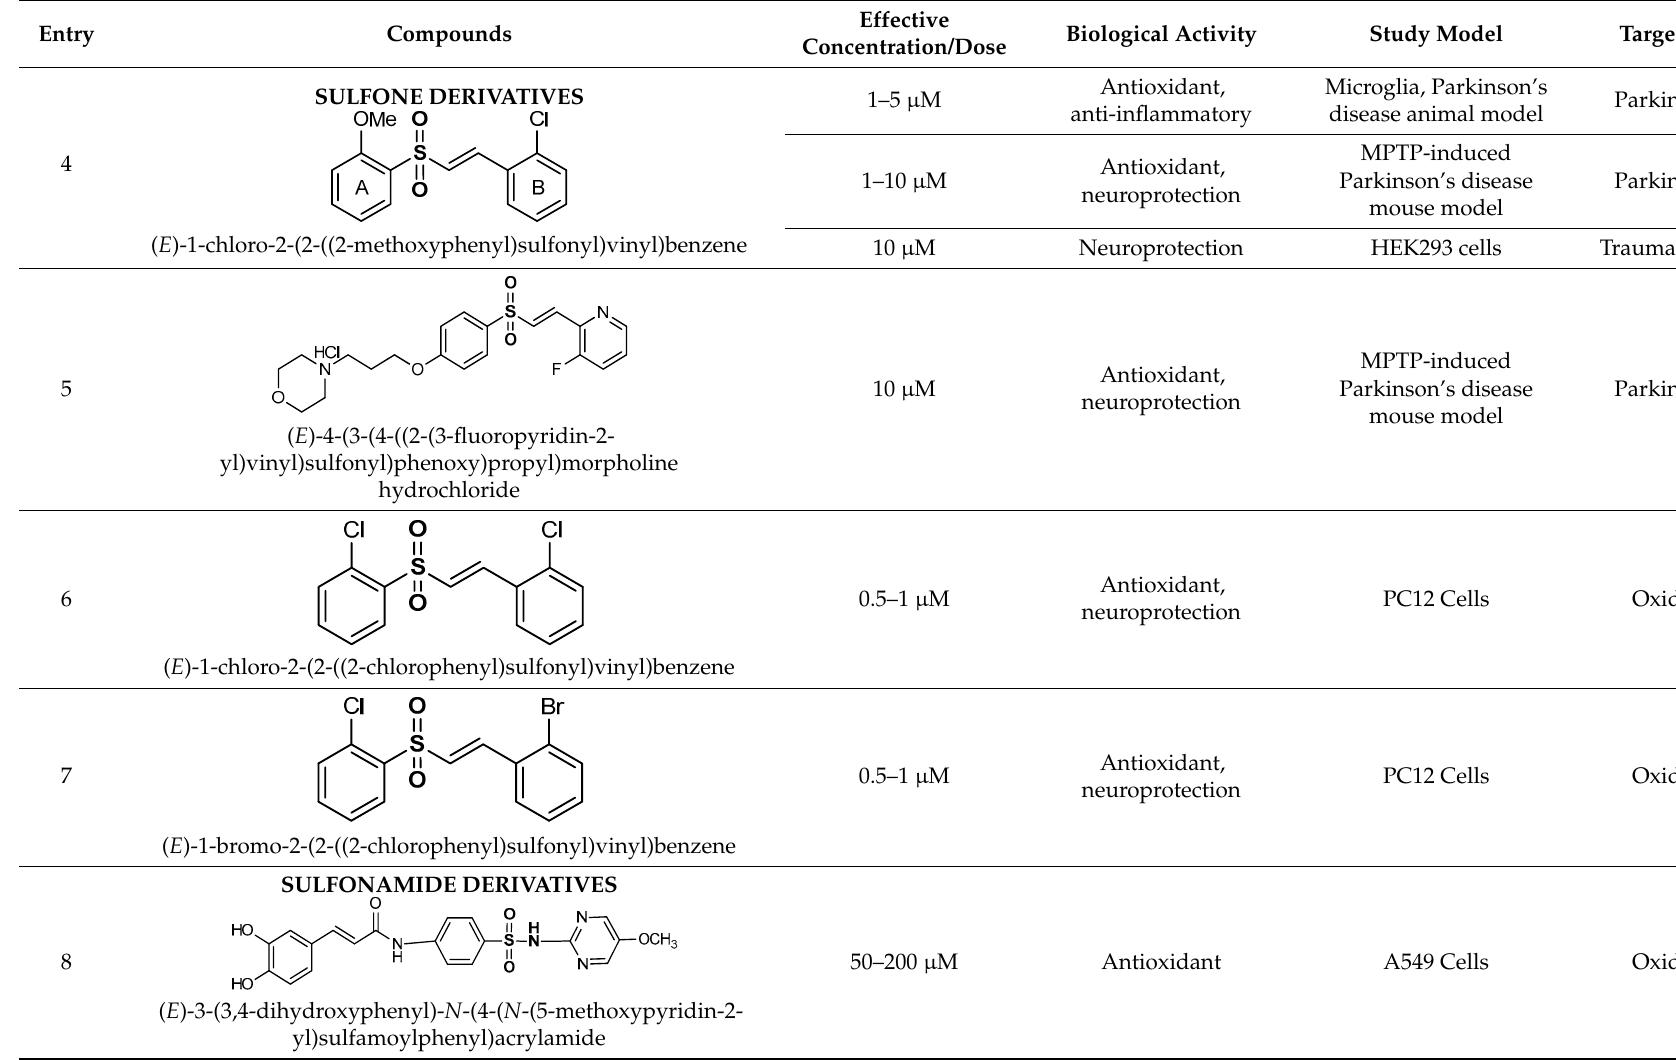
Table 1. Synthetic organosulfur compounds and their Nrf2 activation.